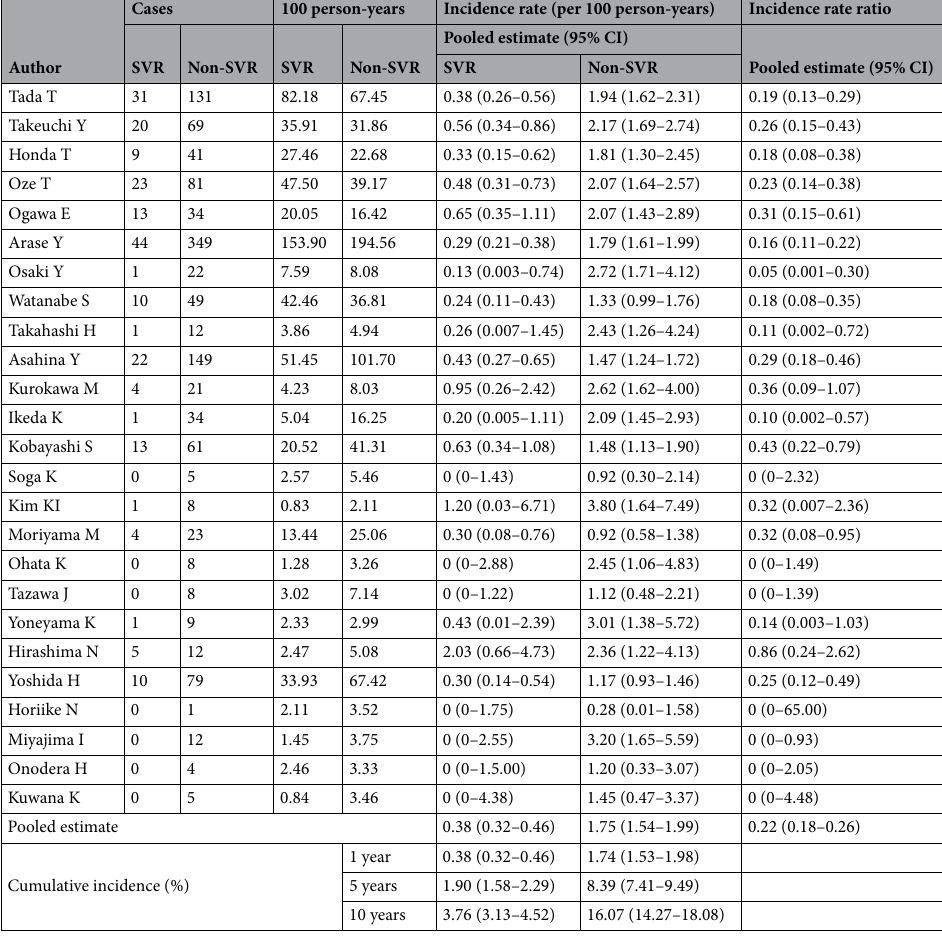
Table 3. Pooled estimates of the crude incidence rate (per 100 person-years) and incidence rate ratio of HCC in patients treated with antiviral therapy (SVR vs. non-SVR) calculated using data from 25 studies. HCC hepatocellular carcinoma, SVR sustained virologic response, CI confidence interval.